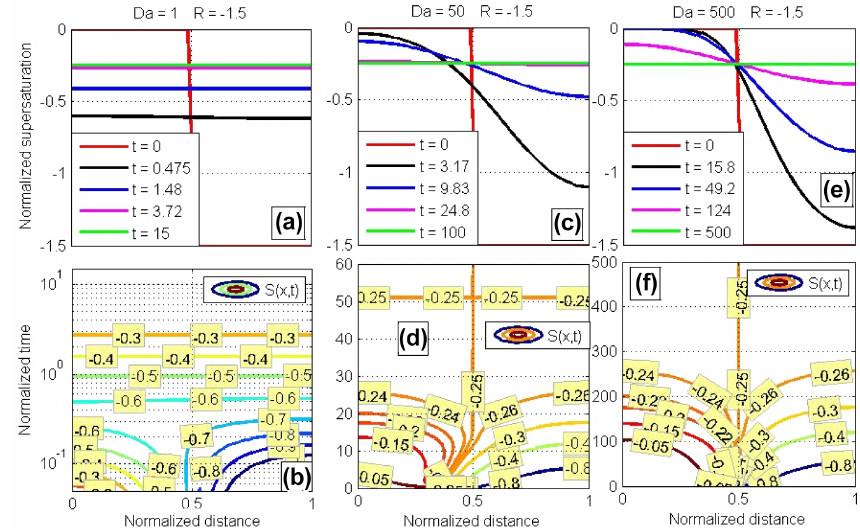
Figure 3. Horizontal dependencies (upper row) and e x − e t dependencies (lower row) of normalized supersaturation at Da = 1, Da = 50 and Da = 500 and at R = − 1 . 5. Panel (b) is plotted in semi-log scale.